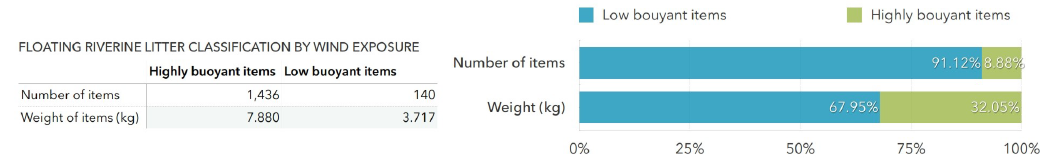
Figure 4. Riverine litter classification based on the exposure to the wind effect. Items were collected from the barrier located in the Deba River (Gipuzkoa) between April and June 2018.